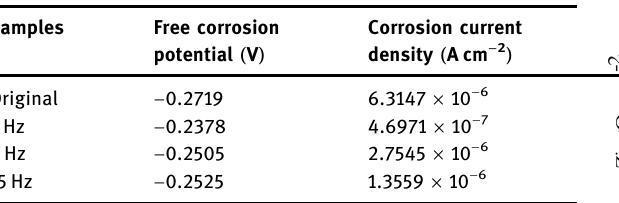
Table 2: The free corrosion potential and corrosion current density of brass alloy with 500 V EPT Samples